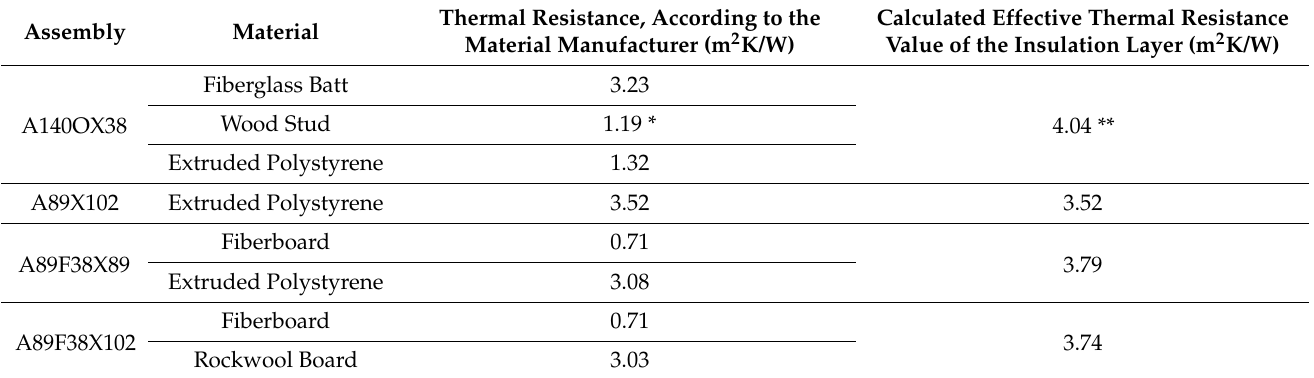
Table 1. The thermal resistance values of the materials, as provided by the manufacturers, and the calculated effective thermal resistance values of the insulation